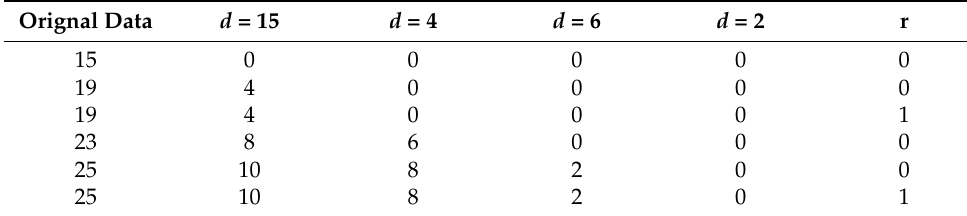
Table 2. An example of AOZS algorithm.